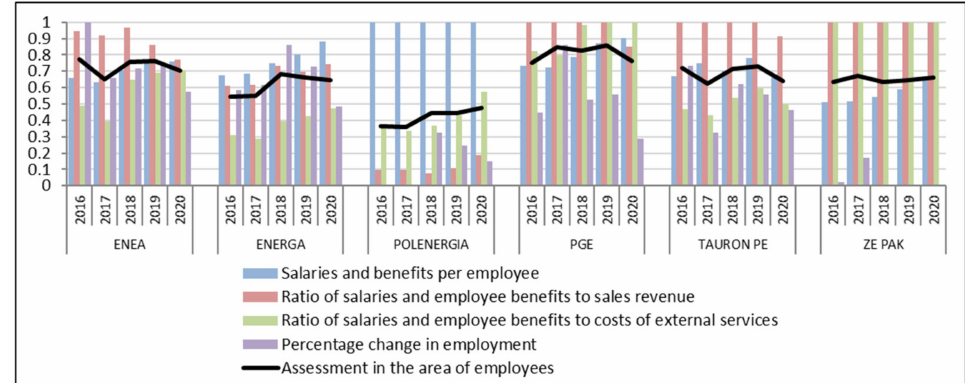
Figure 6. Assessment of the investigated companies’ activities in the area of